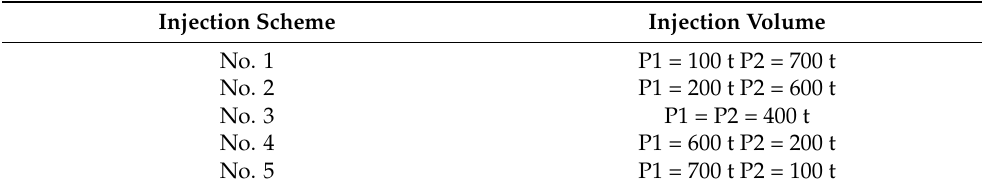
Table 8. Injection volume allocation.